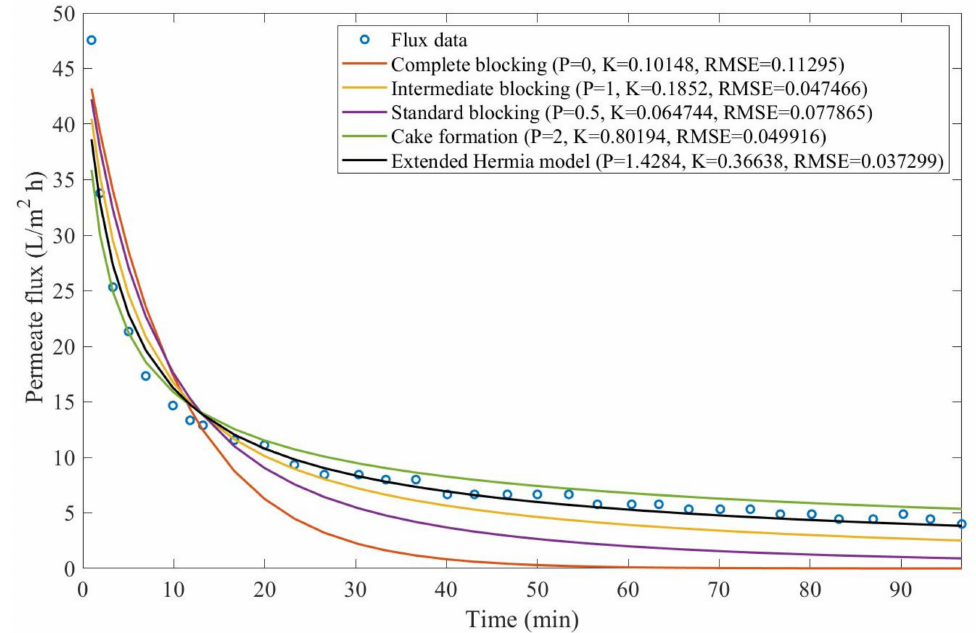
Figure A18. Model fitting for oily effluent ultrafiltration with CFR of 28 L/min and 21 kPa considering the four original pore-blocking mechanisms and the extended Hermia model (17).